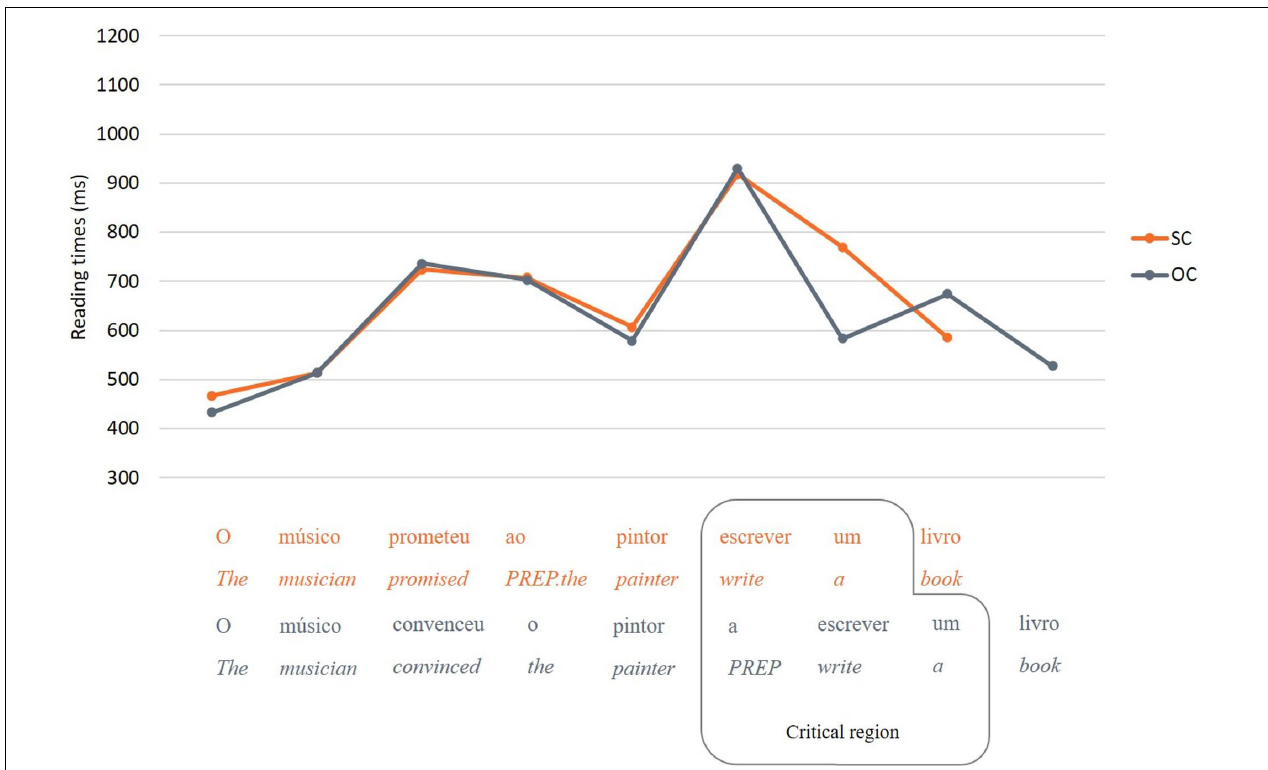
FIGURE 7 | Mean reading times per word for SC and OC